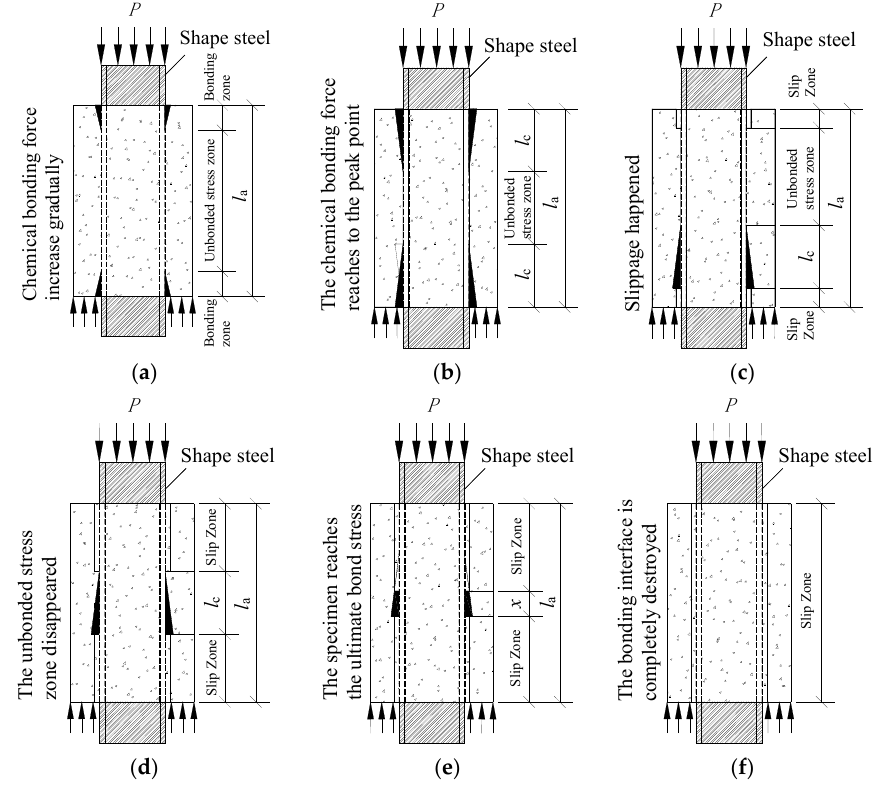
Figure 8. Failure process of specimen, they should be listed as: ( a ) Bonding stress increase; ( b ) slip critical state; ( c ) slippage happened; ( d ) the unbonded stress zone disappeared; ( e ) ultimate bonding state; ( f ) residual